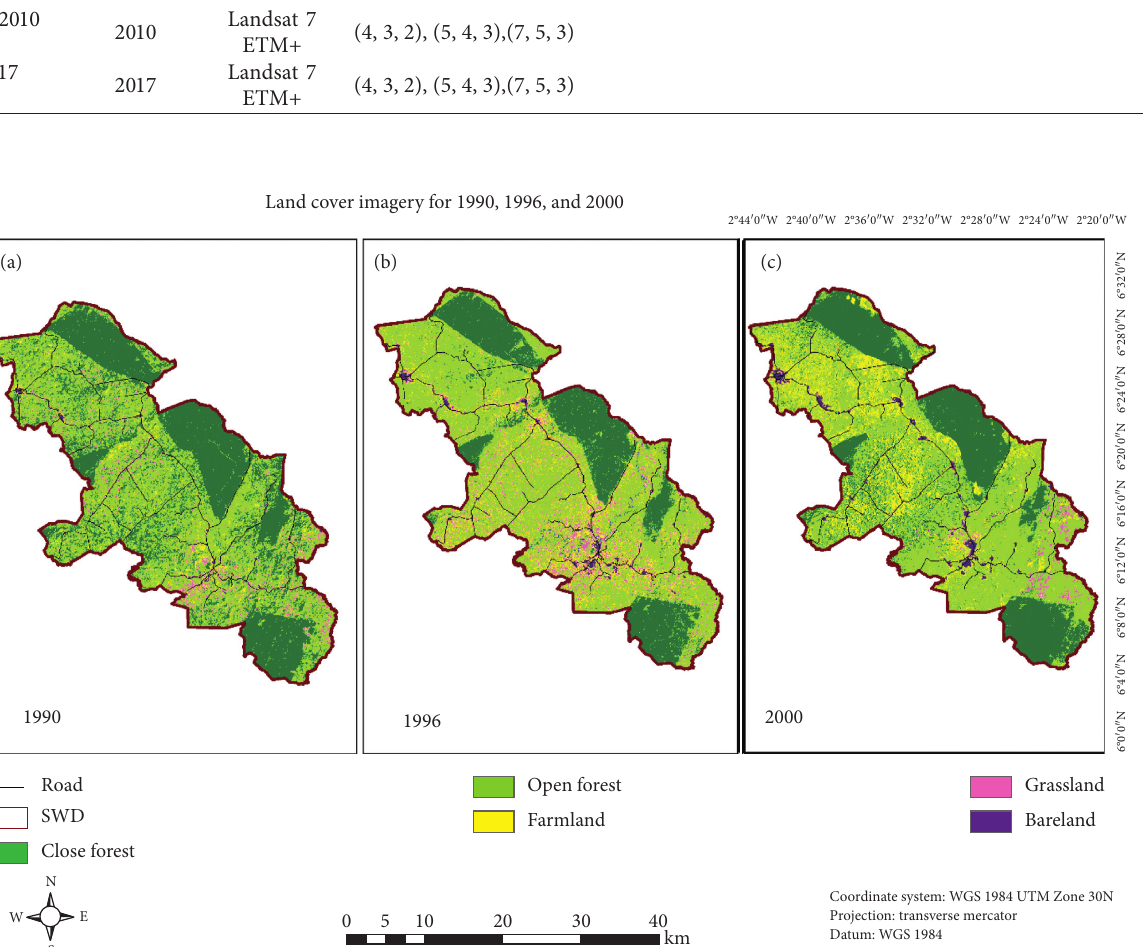
Figure 2: Classified SWD LULC image for (a) 1990; (b) 1996; and (c) 2000.